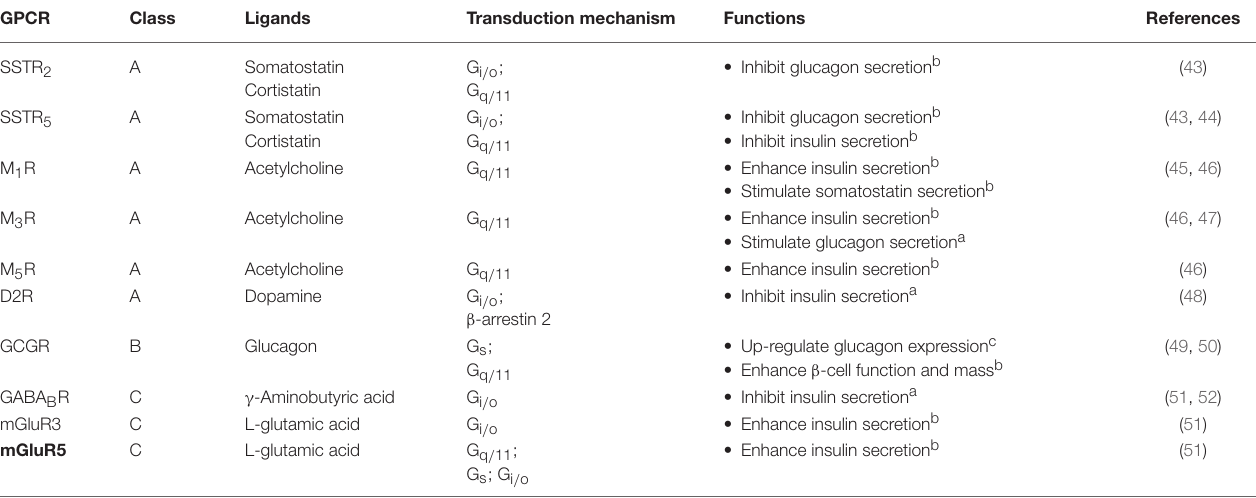
TABLE 2 | Examples of GPCRs in the pancreatic islet for regulating pancreatic hormone secretion.